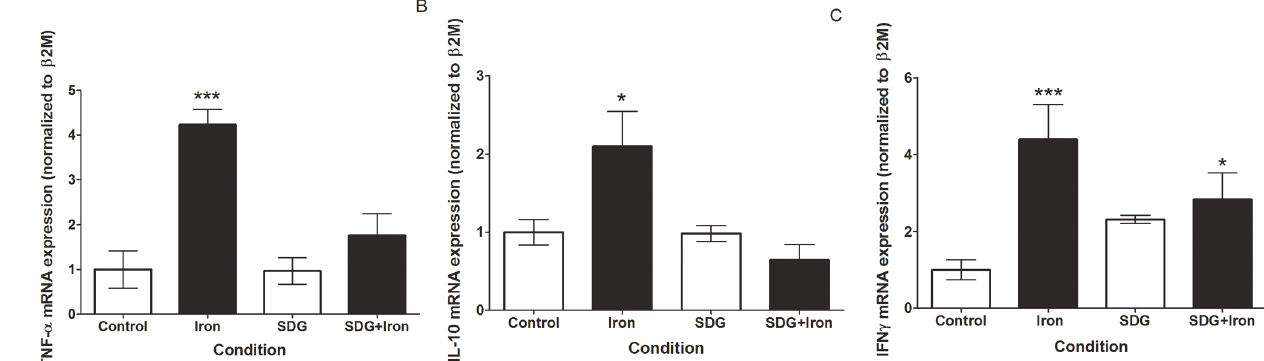
Fig 4. SDG decreases iron-induced inflammatory cytokine gene expression in H9c2 cells. Gene expression of inflammatory cytokines in control, 50 μ M iron-treated, 500 μ M secoisolariciresinol diglucoside (SDG), and SDG pre-treatment + iron-treated H9c2 cells. mRNA levels of tumor necrosis factor (TNF)- α (A), interleukin (IL)-10 (B), and interferon (IFN) γ (C) were determined via quantitative real-time PCR and normalized to β 2-microglobulin, with normal expression standardized to the control. ( *** = p < 0.001 versus control; * = p < 0.05 versus control, n =